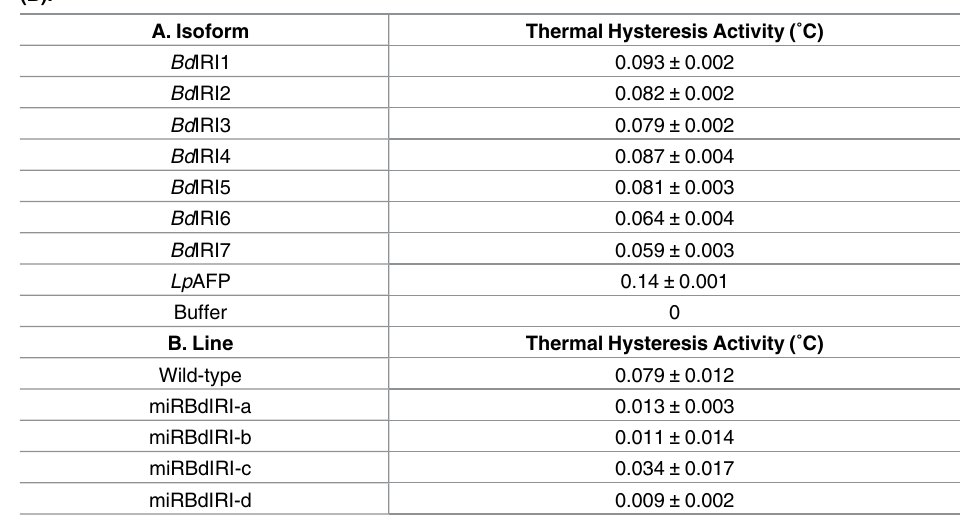
Table 1. Thermal hysteresis readings for recombinant proteins (A) and crude cell lysates of plants